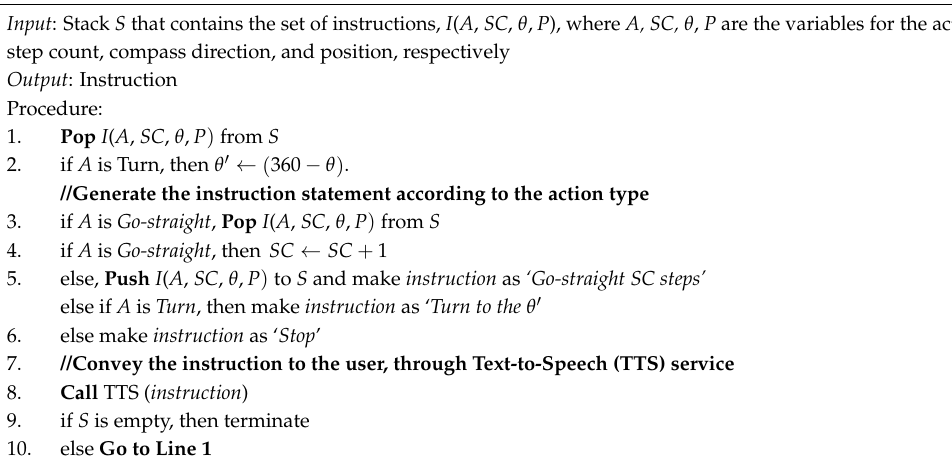
Algorithm 2: The proposed trace backward